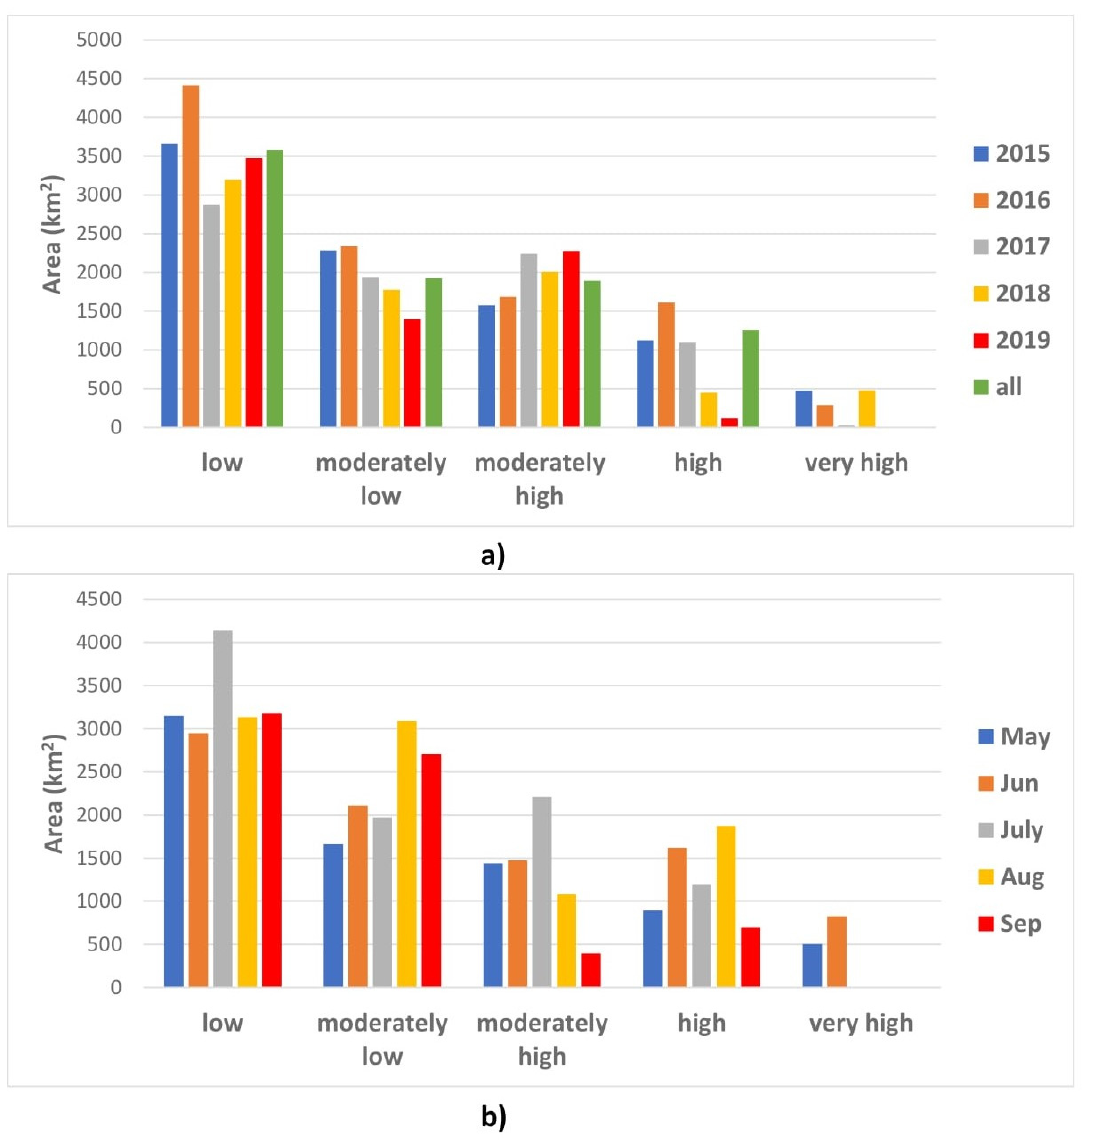
Figure 7. The areas of the upwelling frequency maps generated for ( a ) the inter-annual variation (Figure 9) and ( b ) the monthly variation (Figure 8).